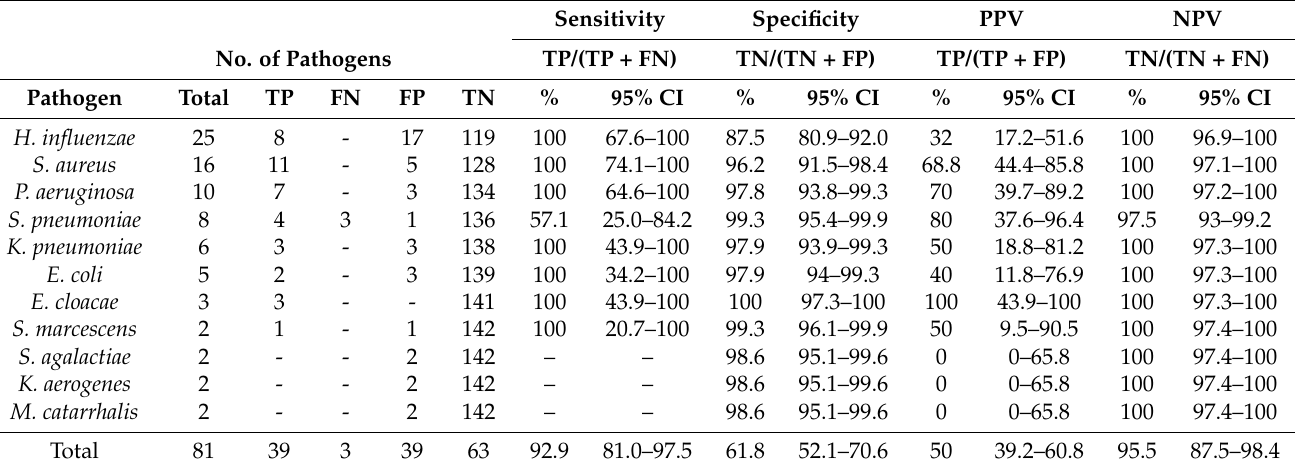
Table 2. Performance summary of the FAPP+ versus those of the conventional